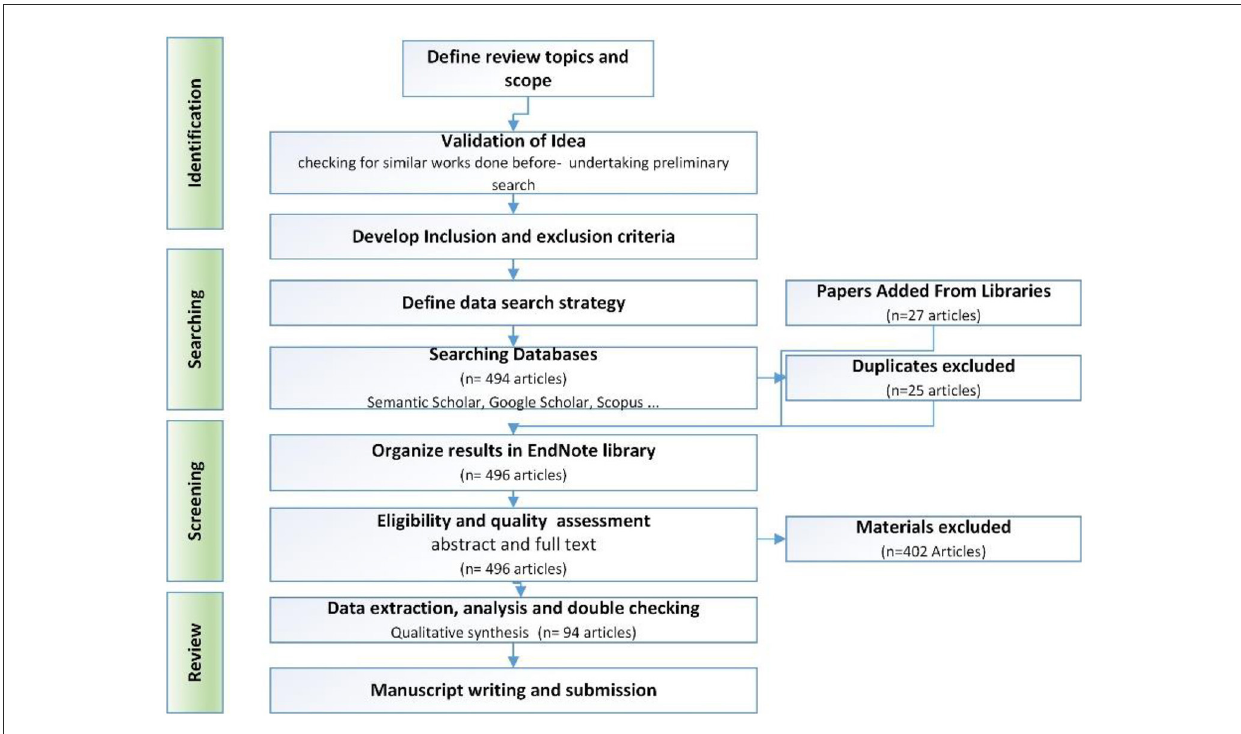
FIGURE2 Simplified review flow